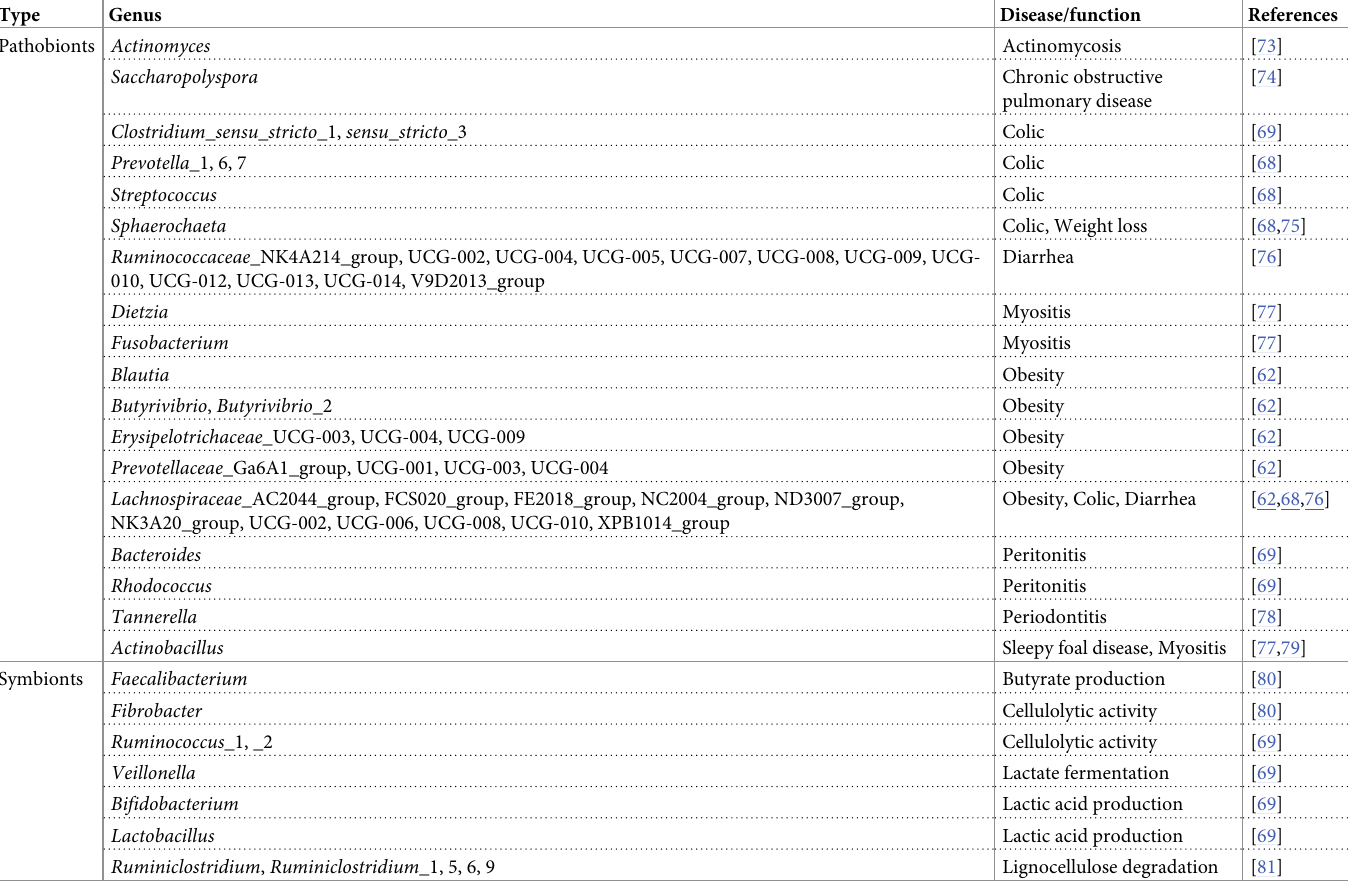
Table 4. Pathobionts and symbionts in FATPHs and